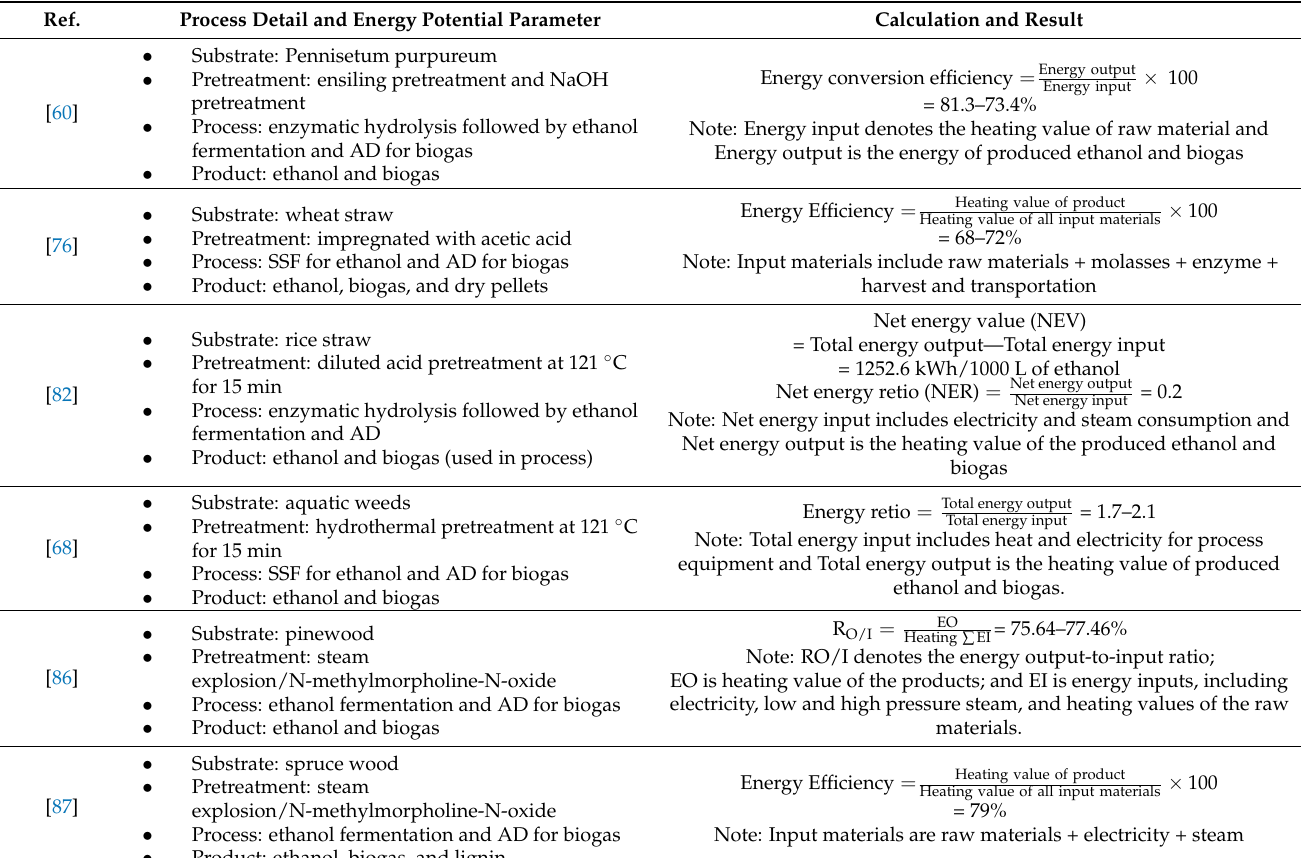
Table 2. Energy efficiency indicators used in net energy analysis of co-production of 2G bioethanol and biogas.